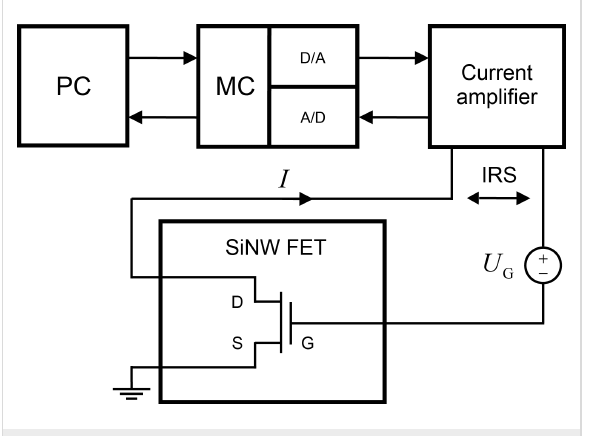
Figure 8: Conceptual diagram of the measurement setup. Because the measurement card was not directly suitable for measuring very small currents, an amplifier was designed to interface with the measurement setup. The amplifier can measure currents in the range of 1–1000 nA (at an excitation voltage level of ±1 mV). Figure 9 shows a simplified schematic of the amplifier. The upper operational amplifier in the schematic works as an excitation voltage buffer, which drives the ground-referred unknown impedance Z x through a current sense resistor R sense . The measured current causes a voltage drop in this resistor, which is then amplified with the lower instrumentation amplifier. C c and R c are added to prevent oscil- lation in case Z x is highly capacitive. Excitation voltage scaling, power supplies, filtering, and additional amplifier stages are not included. The amplifier has a selectable gain of − 1.1 mV/nA or − 4.5 mV/nA. The bandwidth depends on the impedance to be measured, and varies in the range from 10 to 100 kHz.